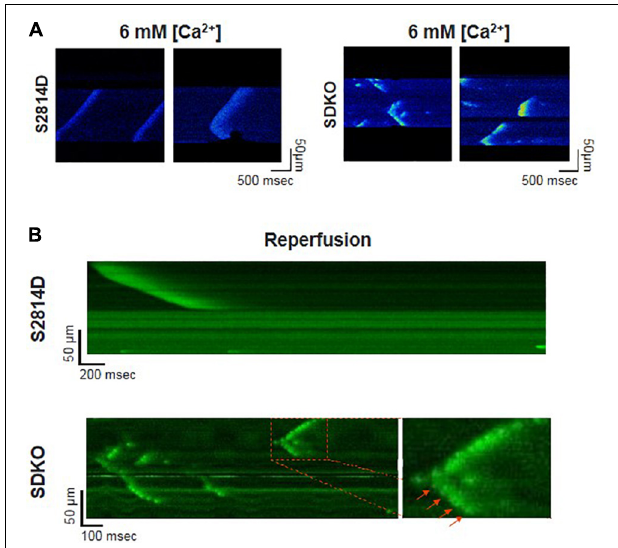
FIGURE 6 | Confocal assessment of spontaneous SR Ca 2 + waves. (A) Representative confocal images showing Ca 2 + waves in isolated cardiomyocytes from S2814D myocytes (left panel) when exposed to 6 mM extracellular Ca 2 + . When SDKO isolated myocytes are exposed to the same condition, they exhibit miniwaves instead of full propagating Ca 2 + waves (Reproduced with permission from Mazzocchi et al., 2016). (B) Representative confocal images of epicardial Ca 2 + waves in S2814D and SDKO intact isolated hearts during reperfusion after an ischemic period. SDKO hearts display fragmented Ca 2 + waves or mini-waves. Red arrows indicate a series of mini-events conserving a Ca 2 + wave pattern (reproduced with permission from Valverde et al., 2019).